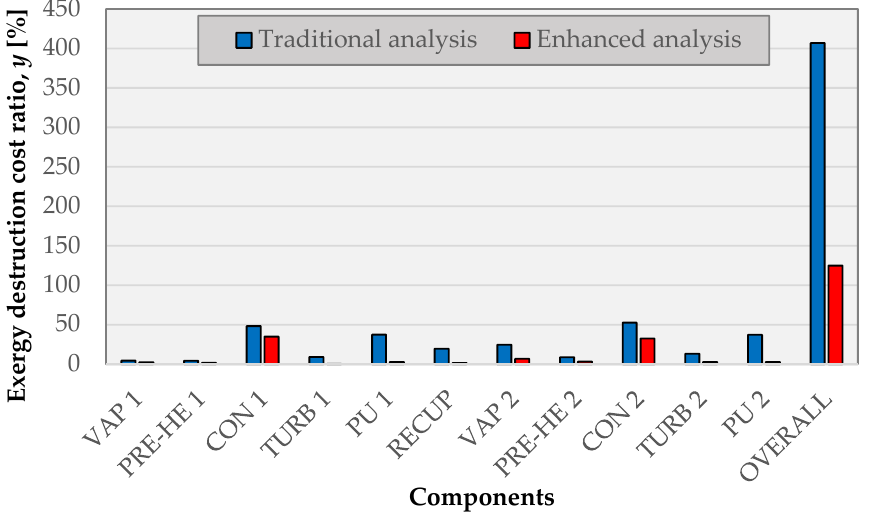
Figure 6. Change in exergy destruction cost ratio for the components for both analyses.